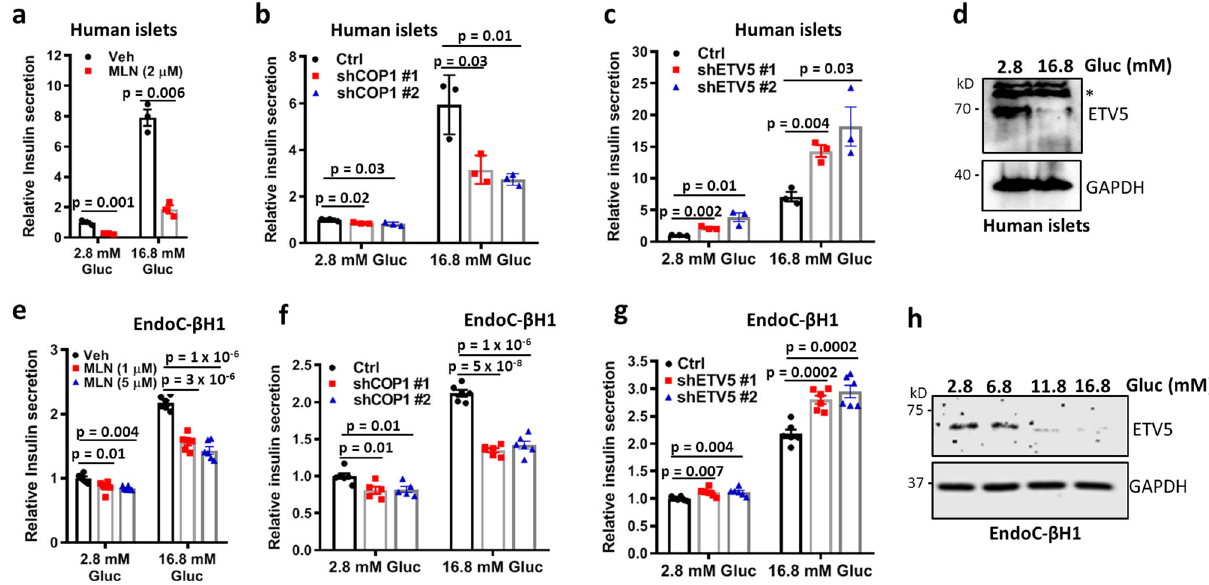
Fig. 6 The CRL4 COP1 – ETV5 axis operates in human islets and β cells. a – c Effects of CRL inhibition ( a ), and COP1 ( b ), or ETV5 ( c ) knockdown on insulin secretion from isolated human islets ( n = 3). Data are presented as mean ± SEM. P values were calculated by two-tailed Student ’ s t test. d High glucose medium depletes ETV5 levels in isolated human islets. An asterisk (*) indicates a nonspeci fi c band. e – g Effects of CRL inhibition ( e ), and COP1 ( f ) or ETV5 ( g ) knockdown on insulin secretion from the EndoC- β H1 human beta cells ( n = 6). Data are presented as mean ± SEM. P values were calculated by two- tailed Student ’ s t test. h High glucose medium depletes ETV5 levels in EndoC- β H1 shown to malfunction in T2D patient β cells with low-exocytotic capacity, whereby upregulated ETV1 suppresses insulin secretion via an in fl ammatory pathway 38 , suggesting a COP1-ETV1 axis preventing β cell failure at later stages of T2D. These insights provide a new window to explore the etiology of potential disease- associated variants of COP1 and ETVs.